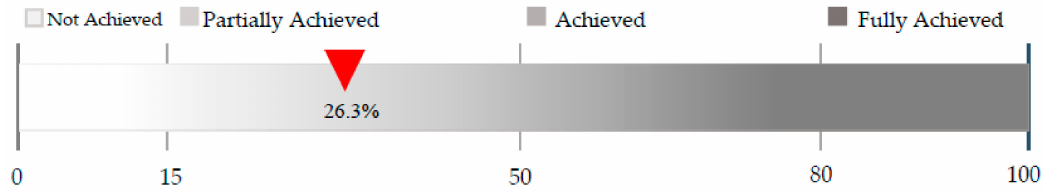
Figure 4. SMEs 4.0 readiness average indicators